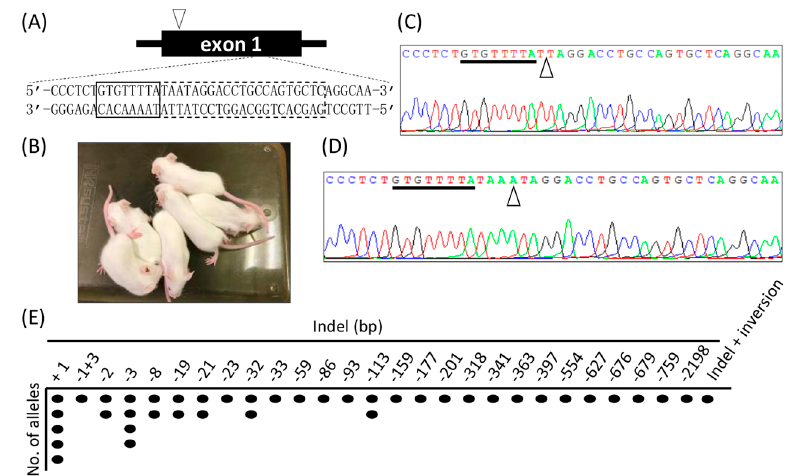
Figure 1. Generation of tyrosinase-KO mice using Cj-CRISPR/Cas. ( A ) Schematics of the target locus in tyrosinase. The box outlined with a dotted line indicates the recognition sequence by gRNA, and that outlined with a solid-line indicates PAM. An arrowhead points to the start codon locus of tyrosinase. ( B ) Some of the offspring by embryo transfer of injected zygotes. ( C ) Waveform data of deletion mutation and ( D ) insertion mutation in the obtained pups. PAM and mutation sites are indicated by underline and arrowheads. ( E ) Suggested mutation patterns in all the offspring.